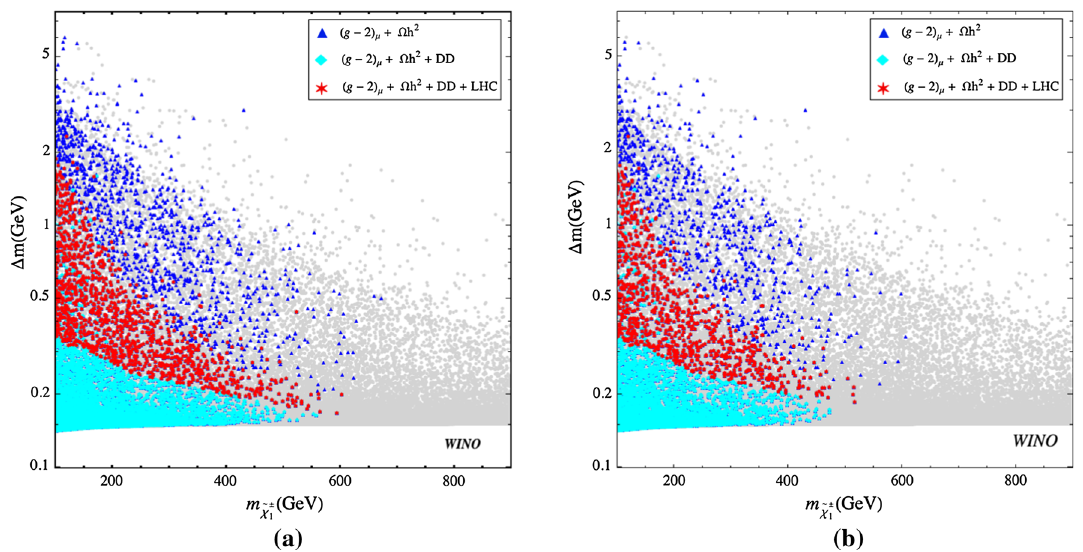
− (cid:6) m ( = m − m ) plane for the wino DM scenario for current (left) and anticipated future ˜ χ 0 ˜ χ ± 1 1 1